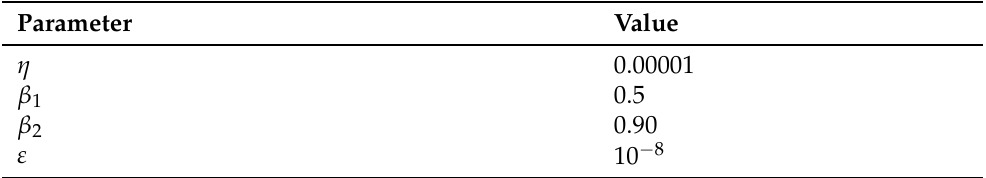
Table 5. Adam parameters for the critic François (2015); Kingma and Ba